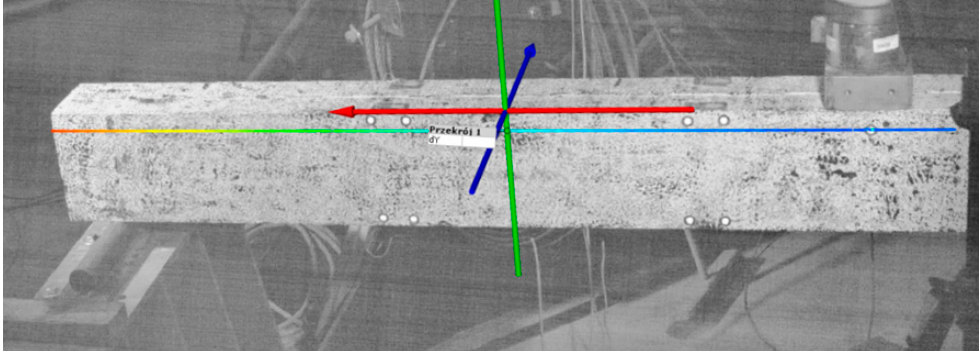
Figure 10. The line along which the deflection line plot was created.